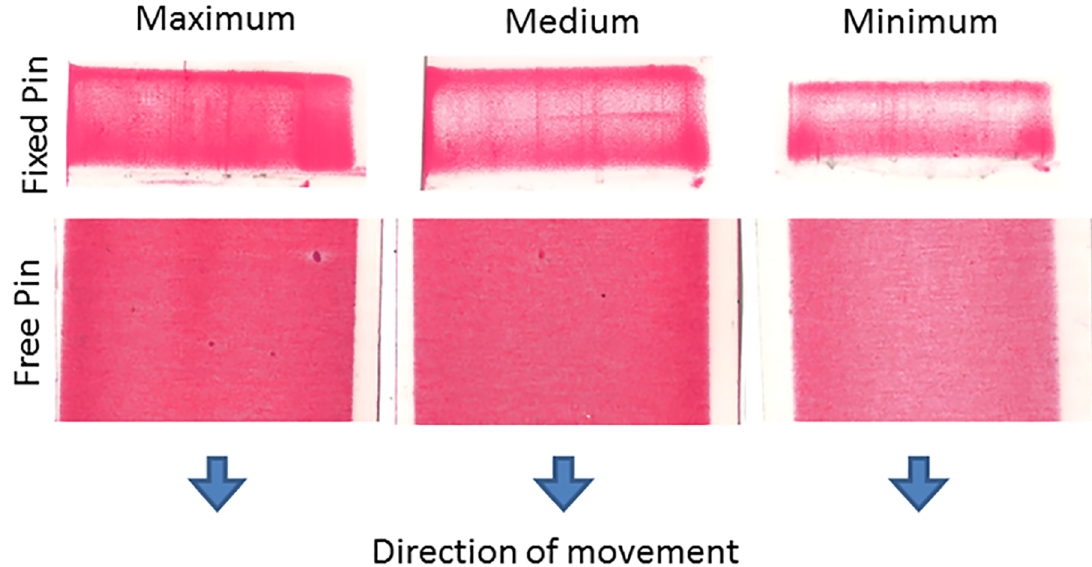
Figure 13. Pressurex® film obtained for each pressure level with fixed and free